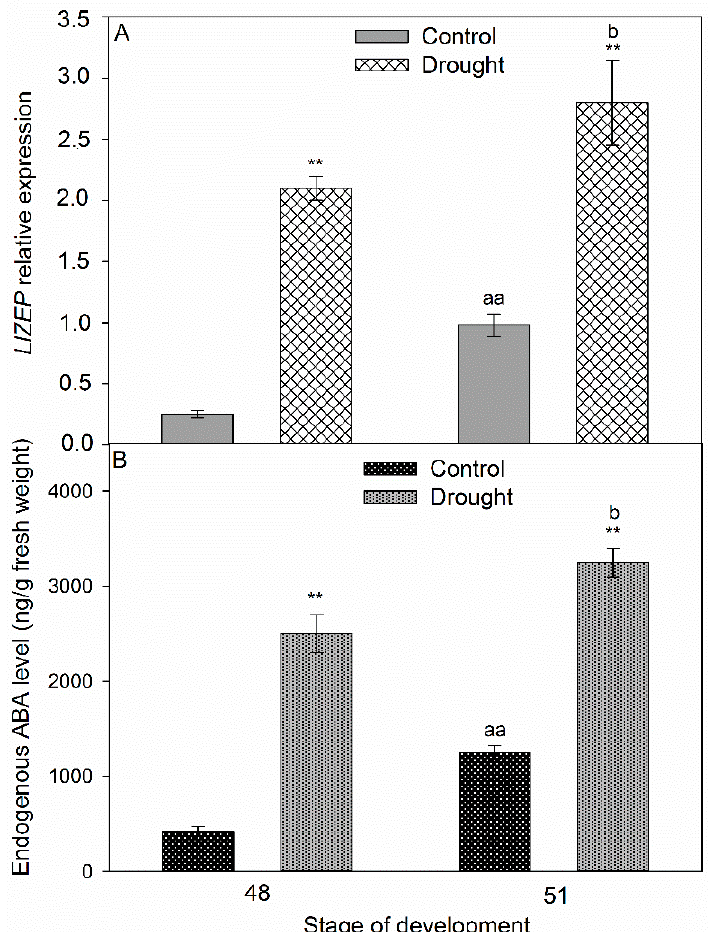
Figure 6. LlZEP expression (related to LlACT ) ( A ) and endogenous content of abscisic acid (ABA) in floral abscission zone (AZ) of Lupinus luteus grown under drought conditions. Control plants were growing in soil of optimal moisture (70% WHC). In parallel, part of plants was subjected to drought for 2 weeks (25% WHC). For analysis, AZs were harvested on the 48th and 51st days of cultivation. Data are presented as averages ± SE. For LlZEP expression, significant di ff erences in stressed plants in comparison to control plants are indicated as ** p < 0.01, significant di ff erences in 51-day-old control plants in comparison to 48-day-old plants are indicated as aa p < 0.01, and significant di ff erences in 51-day-old stressed plants in comparison to 48-day-old stressed plant are indicated as b p < 0.05. For ABA content, significant di ff erences in the stressed plants in comparison to control plants are indicated as ** p < 0.01, significant di ff erences in 51-day-old control plants in comparison to 48-day-old plants are indicated as aa p < 0.01, and significant di ff erences in 51-day-old stressed plants in comparison to 48-day-old stressed plants are indicated as b p < 0.05 (Student’s t- test).